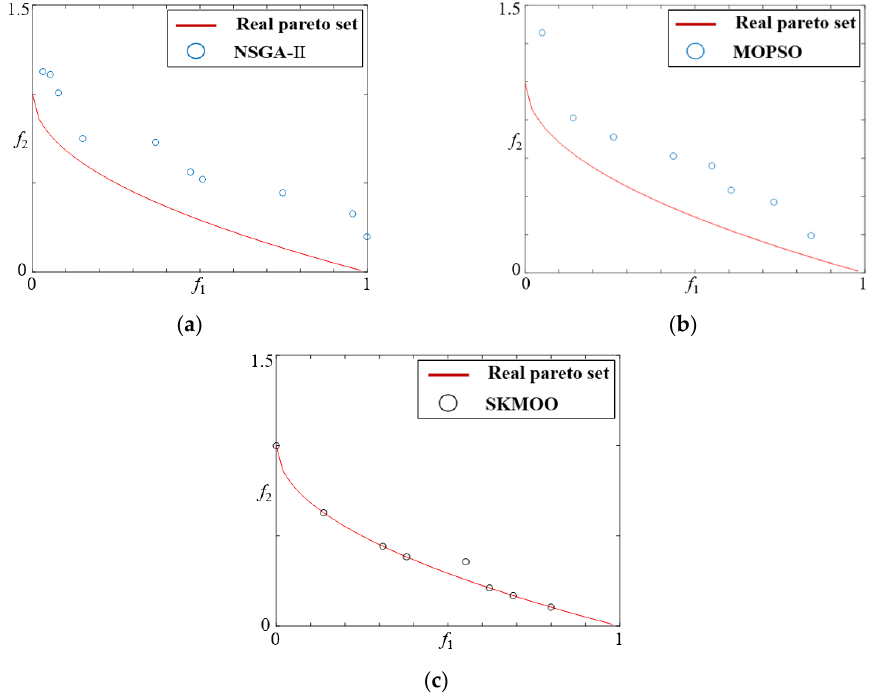
Figure 8. Pareto front set of test function4 ( a ) NSGA-II; ( b ) MOPSO ; ( c ) SKMOO. Table 1. The result of test functions.